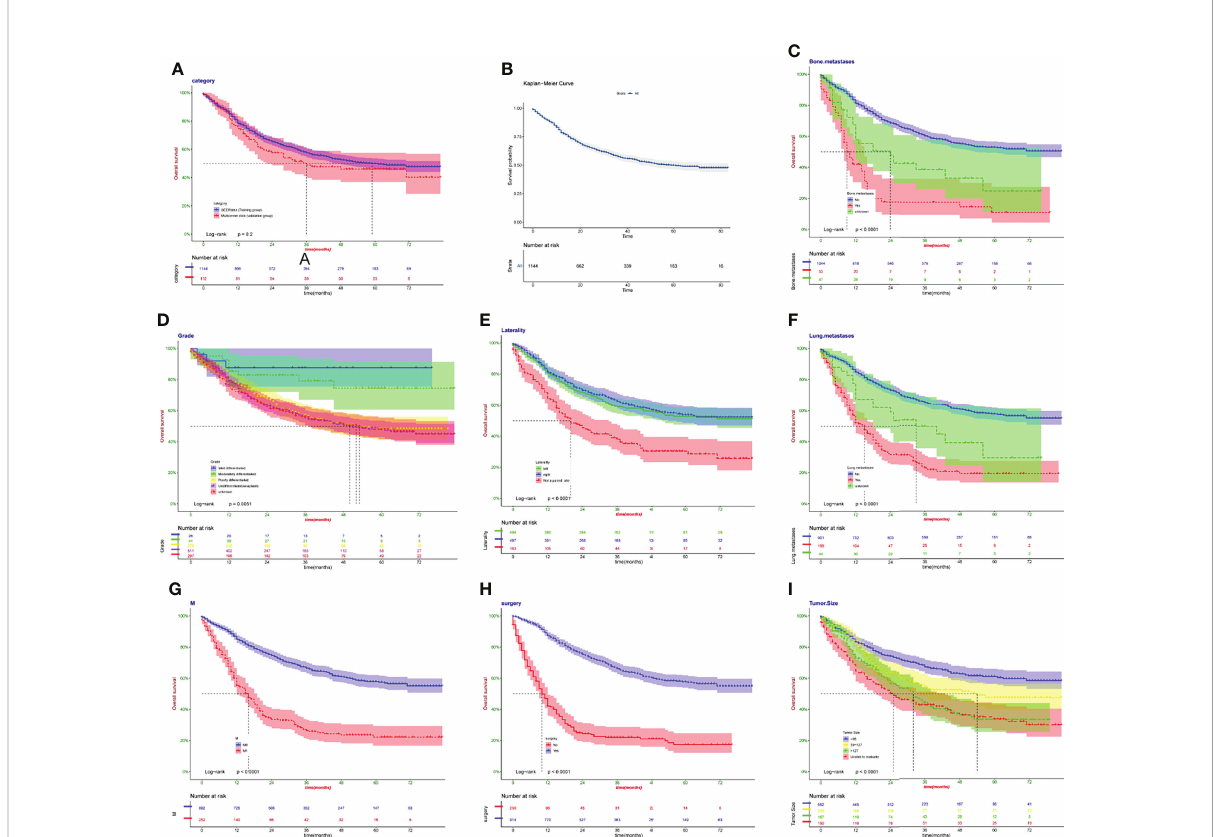
FIGURE 8 Kaplan – Meier survival curves in the training cohort. (A) The SEER data and the real Chinese multicenter data. (B) Patients in SEER data. (C) Bone metastases. (D) Grade. (E) Laterality. (F) Lung metastases. (G) M. (H) Surgery. (I) Tumor